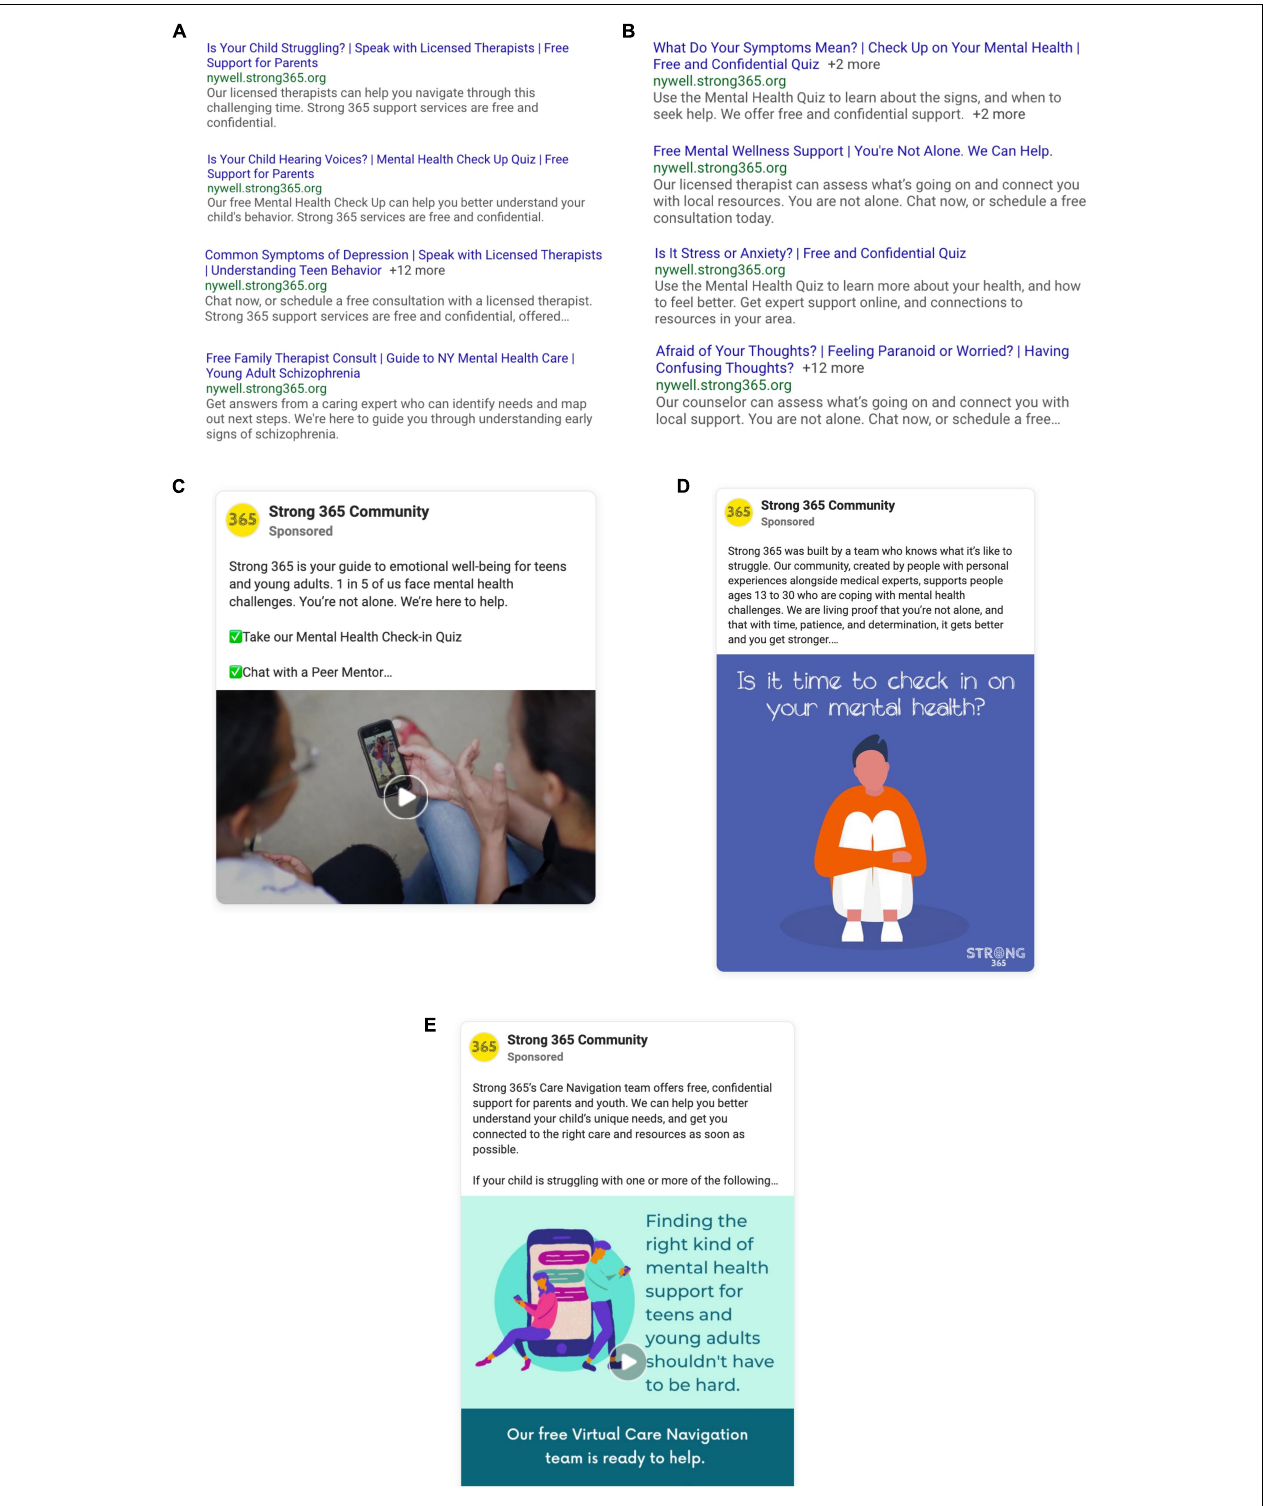
FIGURE 2 | Sample social media and search engine ads. (A) Example Search ads targeting allies such as parents, educators, medical professionals who are searching for mental health-related information. (B) Example Search ads targeting youth who are searching for mental health-related information. (C) Example social media video ad featuring a young person with lived experience sharing their story. (D) Example social media graphic ad inviting young people to take the quiz. (E) Example social media animation ad targeted toward parents of teens and young adults.